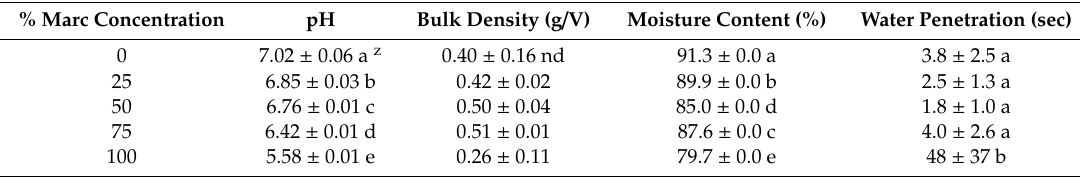
Table 1. Physical properties and pH-values of depleted grape marc and compost blends. ( n = 3, except water penetration n =